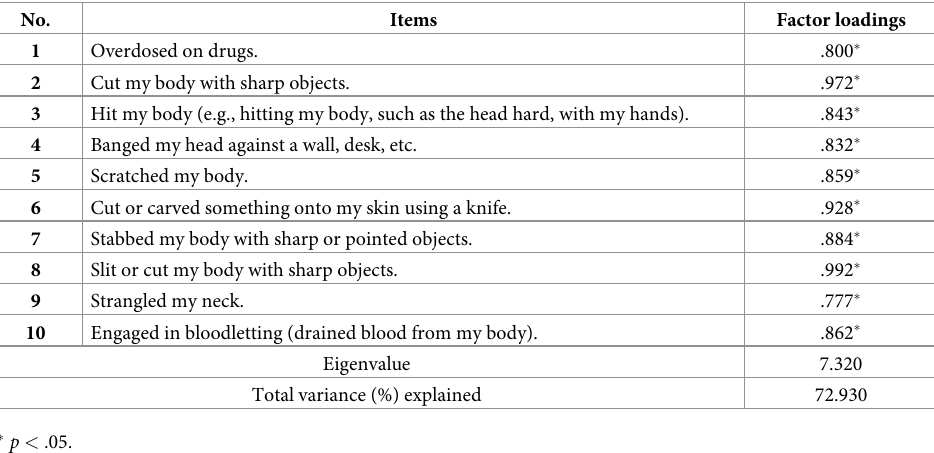
Table 5. Results from the confirmatory factor analysis of the SHSI (N = 514). No. Items Factor